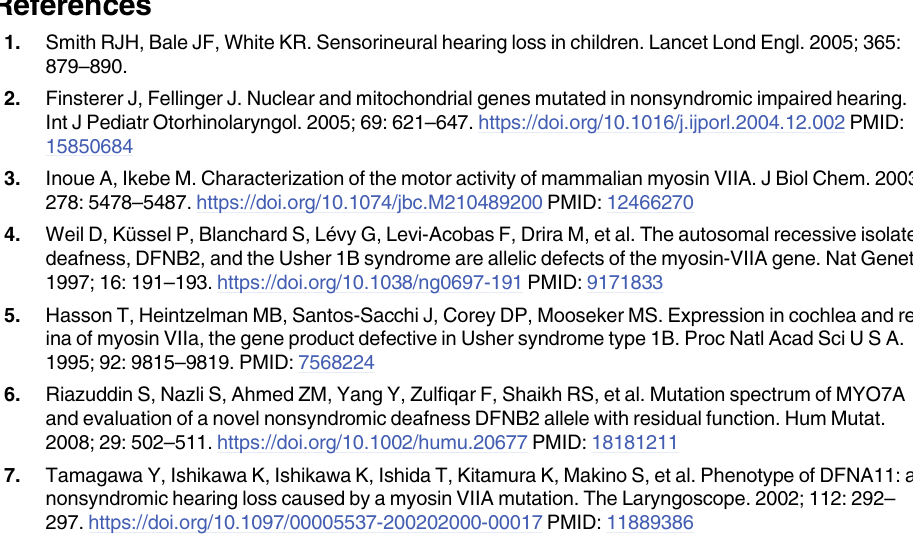
S1 Table. List of primers used to amplify and sequence the MYO7A coding regions. S2 Table. List of the remaining causative variants from the exome sequencing data of the patient SF01.01 before prioritization of reported hereditary hearing loss